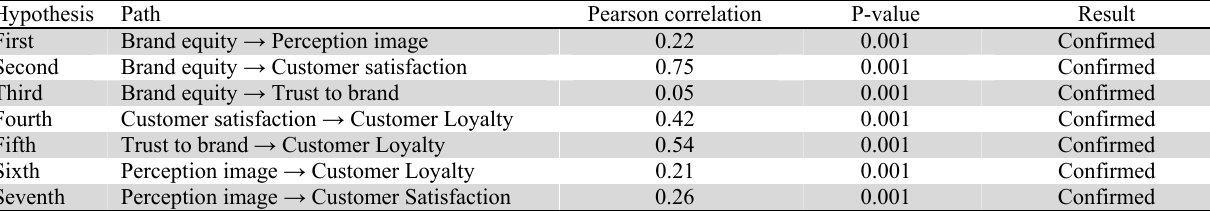
The summary of Pearson correlation ratios